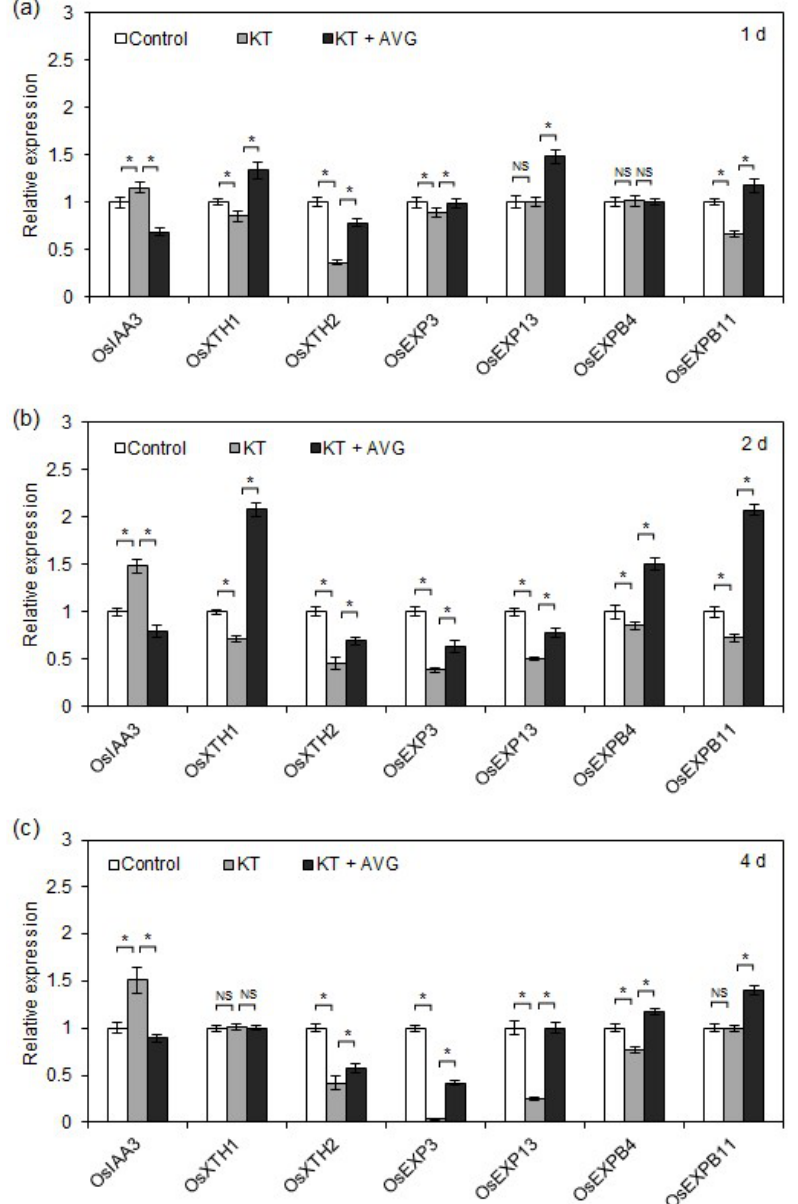
Figure 5. Mitigating effects of AVG on the upregulation of OsIAA3 and downregulation of cell elongation-related genes by exogenous KT in rice seminal roots. Germinated rice seeds were incubated with a solution of KT, KT + AVG, or distilled water as a control. Rice seminal roots were collected after 1 day ( a ), 2 days ( b ), and 4 days ( c ) of growth and qRT-PCR was used to compare the transcription levels of OsIAA3 and cell elongation-related genes in each treatment at each time point. Data are presented as means ± SE. Three biological replicates with three technical replicates were included in the statistical analysis and error range analysis. Significant differences ( p < 0.05) in transcription rates of the same gene in different treatments are indicated by asterisks. KT, treatment of 40 nM KT; KT + AVG, treatment of 40 nM KT plus 50 nM AVG. NS, no significance.